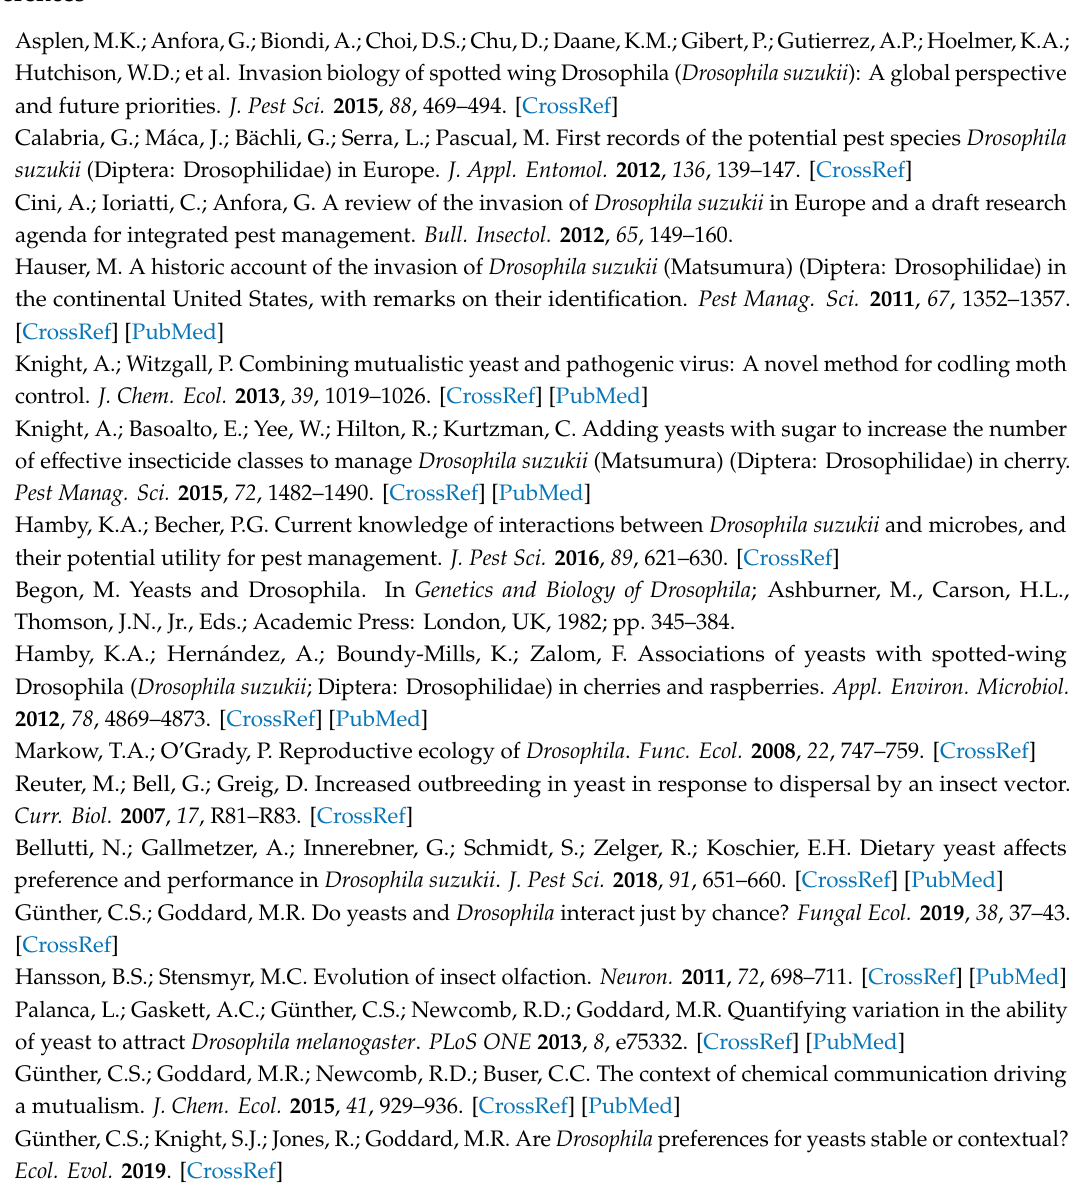
Table S1: Growth of yeast species in YPD medium, Table S2: Statistical analyses applied to results in Figure 2, Table S3: Statistical analyses applied to results in Figure 3, Table S4: Statistical analyses applied to results in Table 3, Table S5: Statistical analyses applied to results in Table